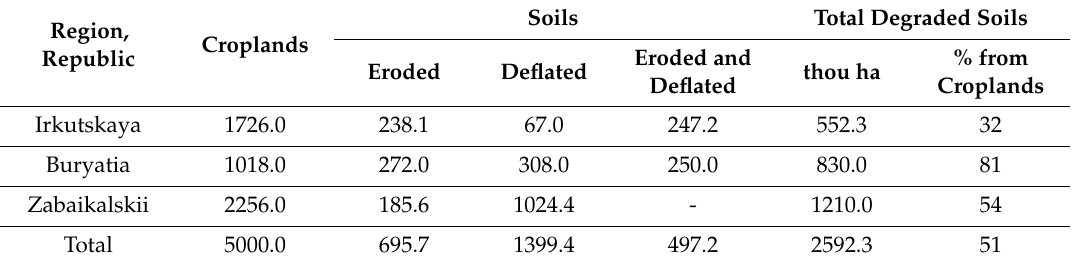
Table 1. Distribution of eroded and deflated soils in some regions of Siberia, thousand ha [18]. Soils Total Degraded Soils Region, Croplands % from Eroded and Republic thou ha Eroded Deflated Croplands Deflated Irkutskaya